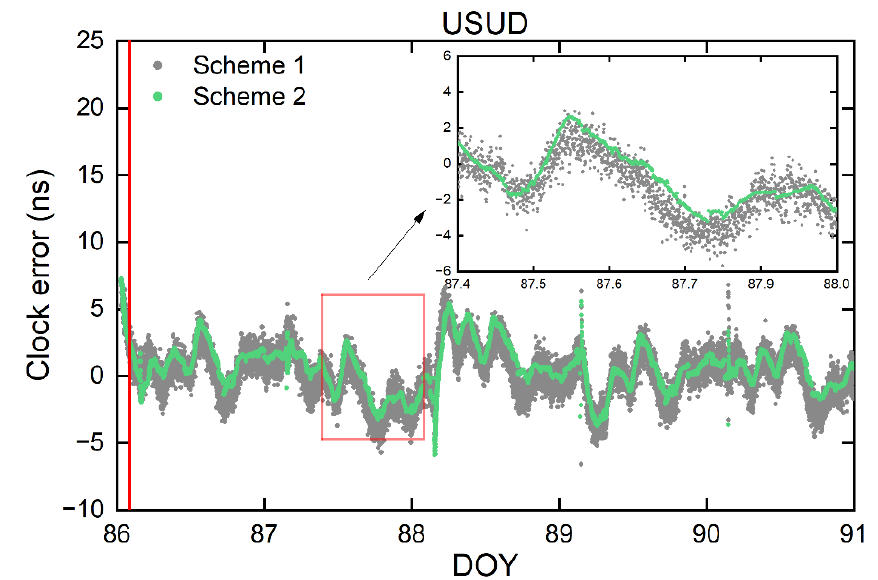
Figure 7. Receiver clock error sequence of USUD station.